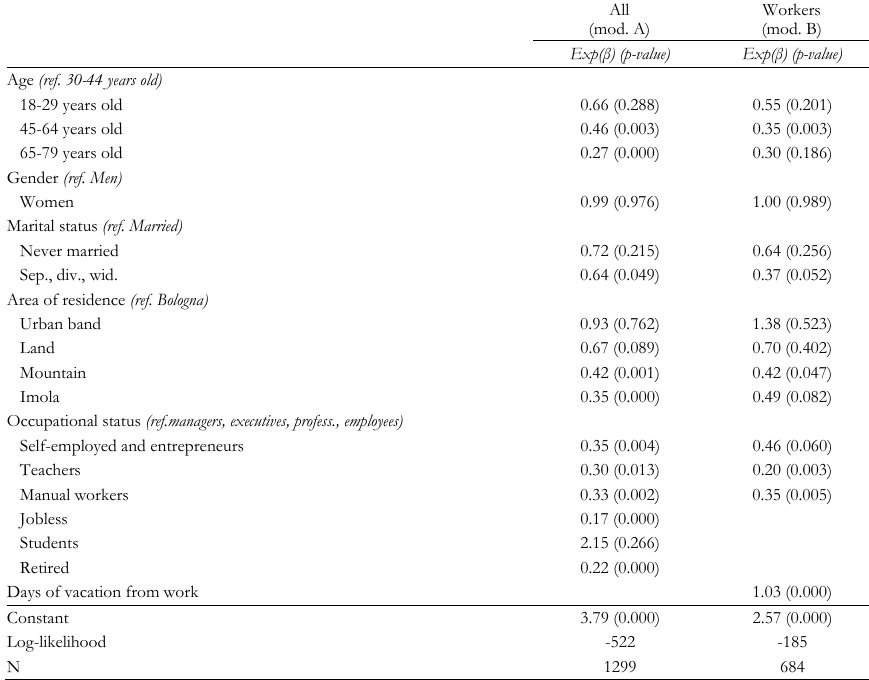
Logistic models: propensity to having taken at least one long holiday during 2003-2004